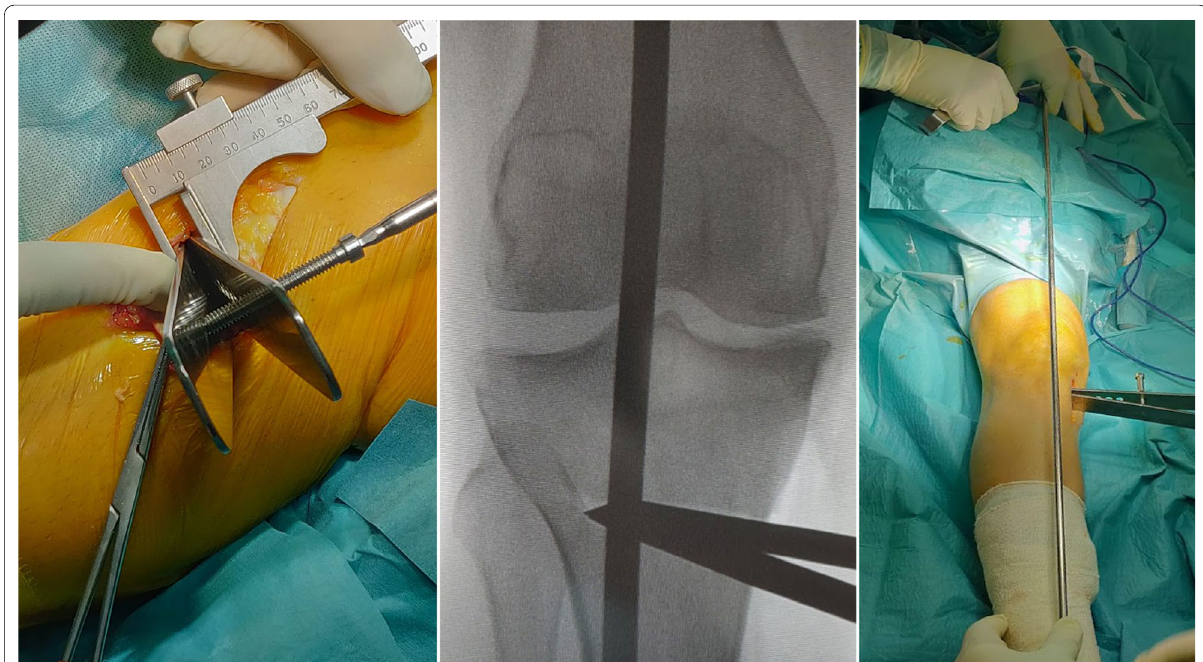
Fig. 7 On the left, intraoperative findings of the distractor positioned and gradually opened into the major horizontal osteotomy site, on a right tibia from medial view. In the middle, the intraoperative alignment fluoroscopic control, verified through the rod guide of a right knee. On the right, the intraoperative finding of the varus correction of the right lower limb, through the distractor and verified through the rod guide